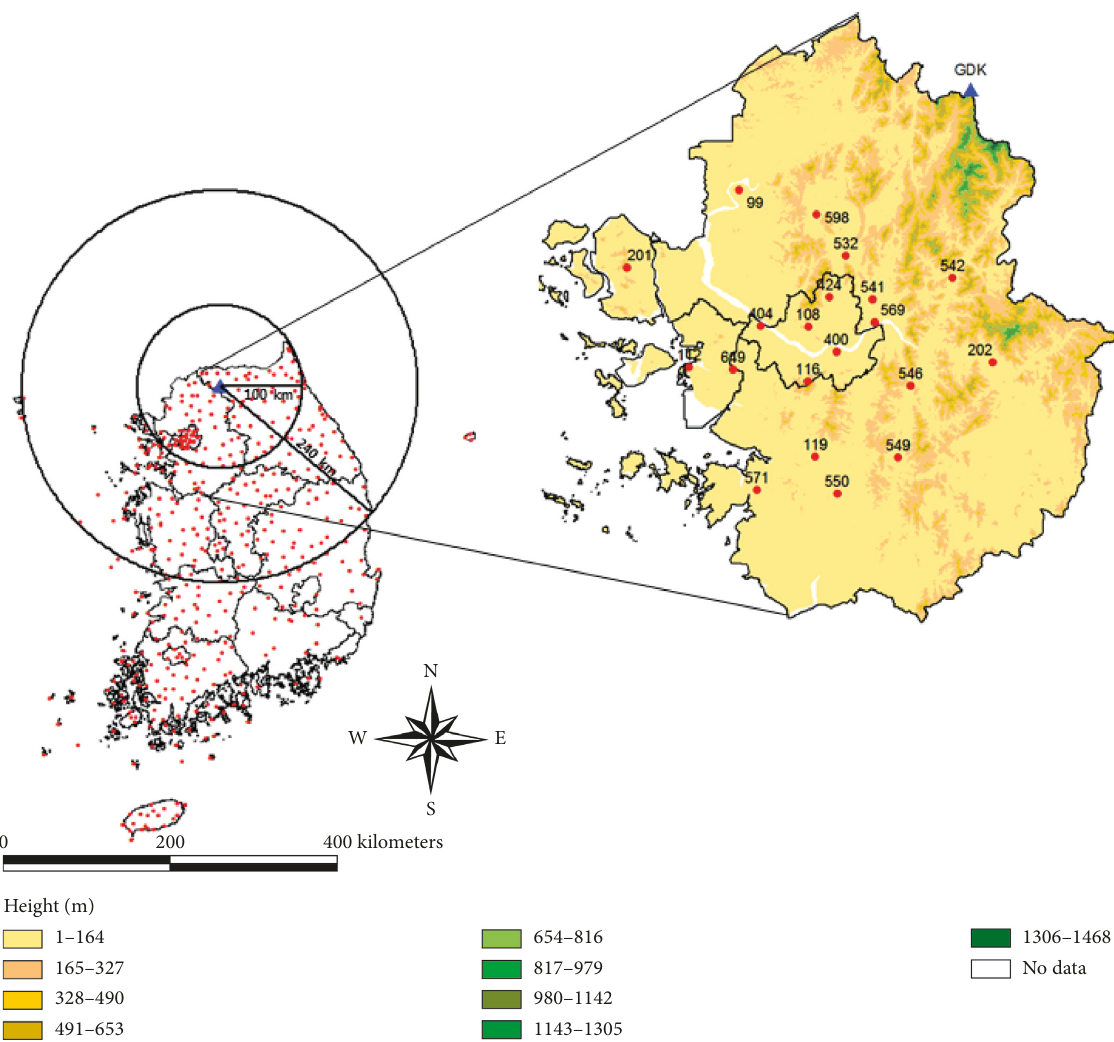
Figure 1: Locations of the Korea Meteorological Administration ground gauge stations (red dots) and Gwangdeoksan (GDK) radar (blue triangle) with its radar umbrella (effective radius:100km; maximum observation radius: 240km). The figure in the right-hand panel presents the locations of the ground gauge stations (red dots) used in the current